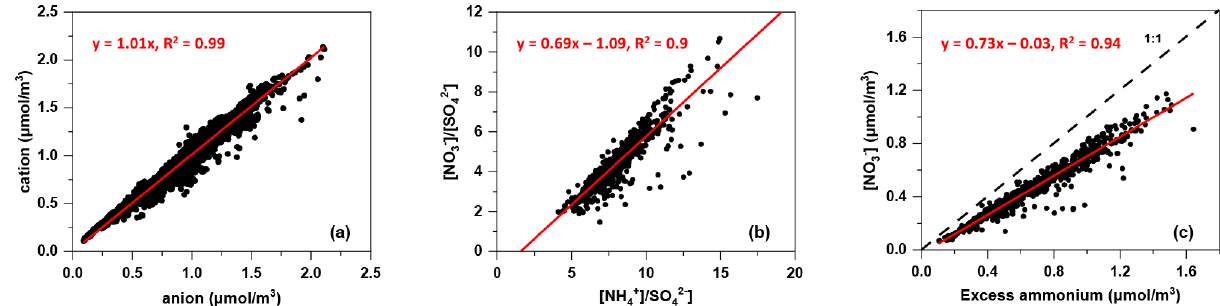
Figure 3. Scatter plots of (a) molar concentrations of cations vs. anions, (b) molar ratios of nitrate to sulfate vs. ammonium to sulfate and (c) molar concentrations of nitrate vs. excess ammonium.